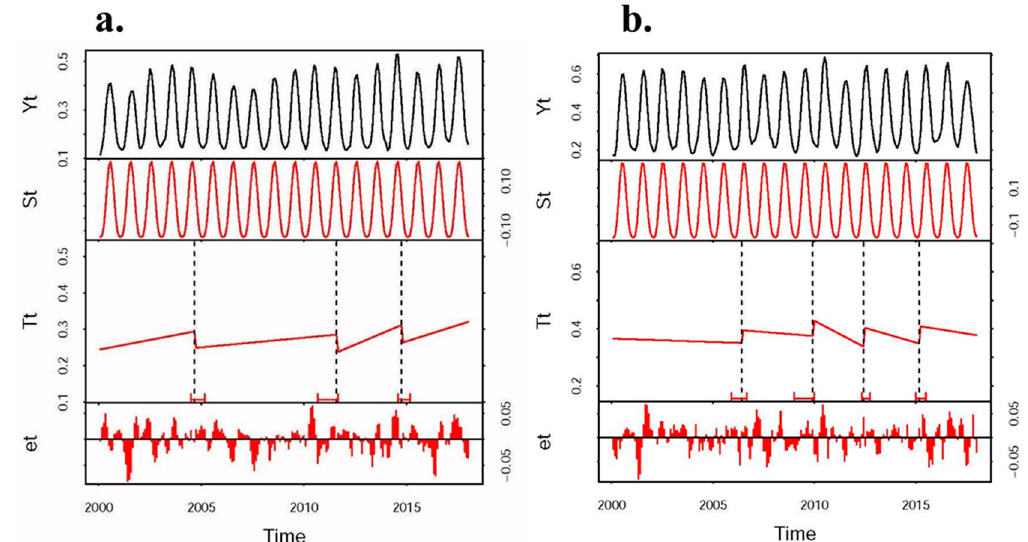
Figure 9. BFAST decomposition results of the NDVI time series from 2000 to 2017 for a pixel with a negative magnitude ( a ) and a positive magnitude ( b ) of major abrupt changes.